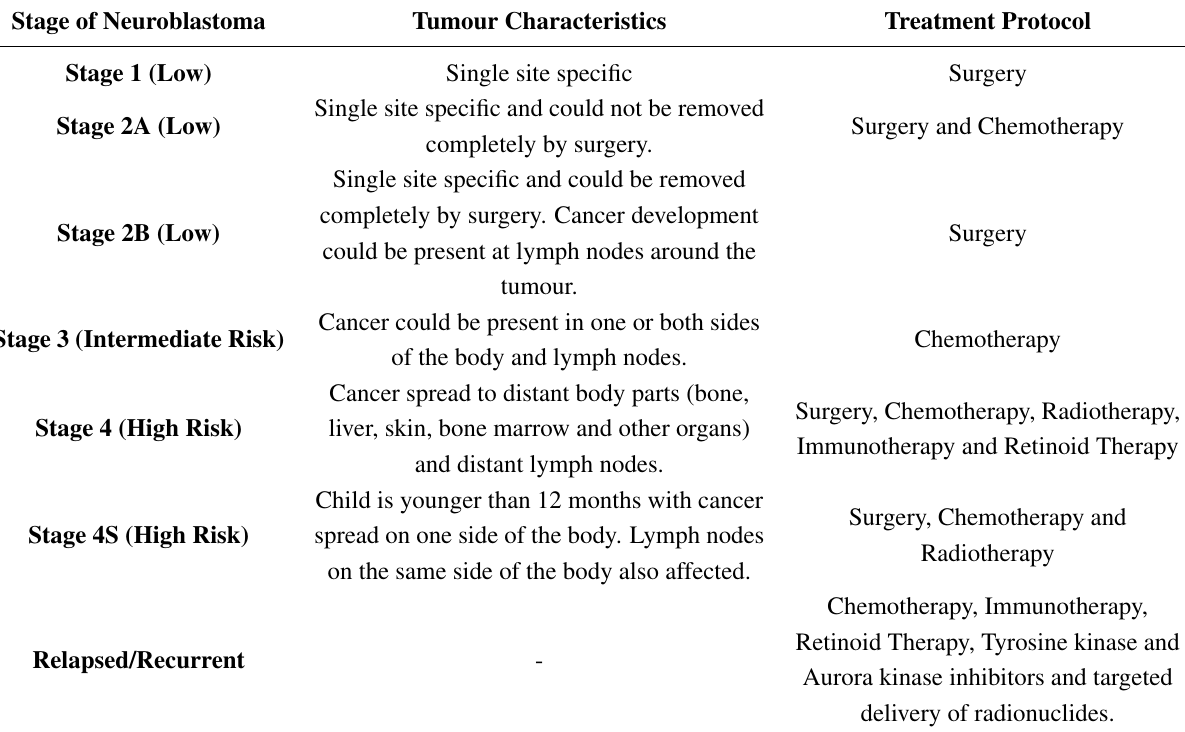
Table 4. Different stages in the development of